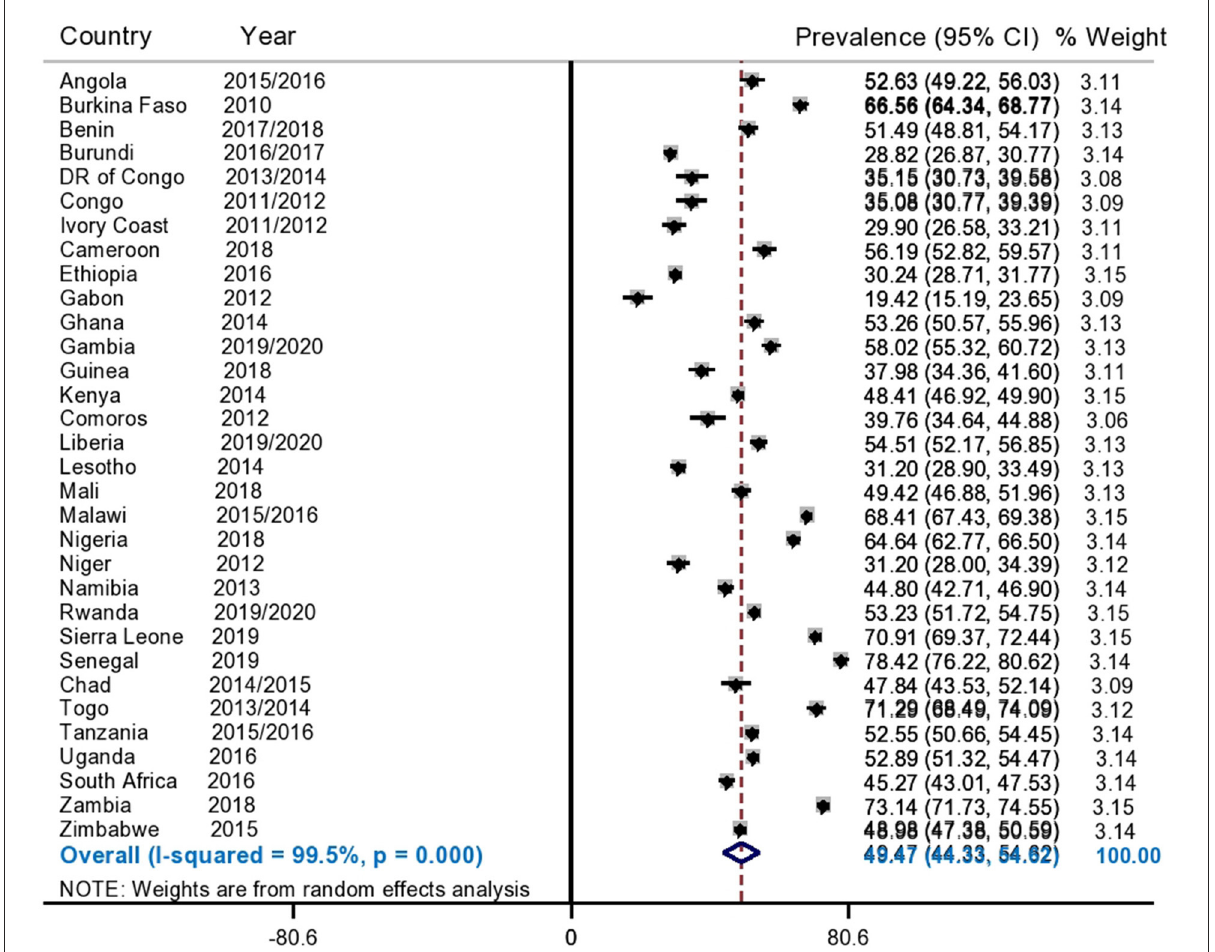
FIGURE1 Forest plot showed that, the pooled prevalence of informed choice of contraceptive methods among reproductive age women in